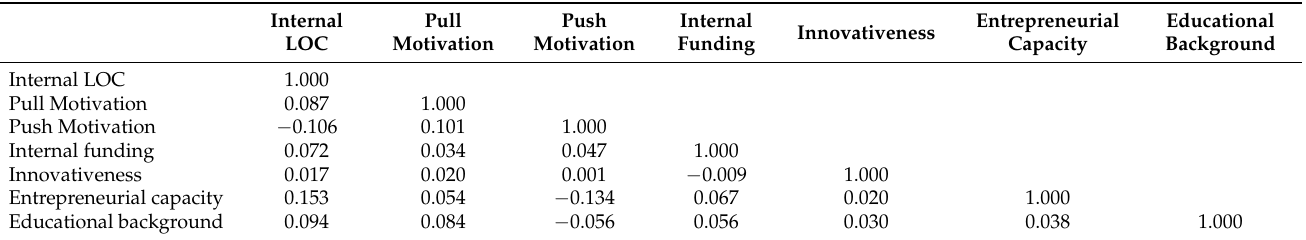
Table 6. Pooled within-groups matrices.